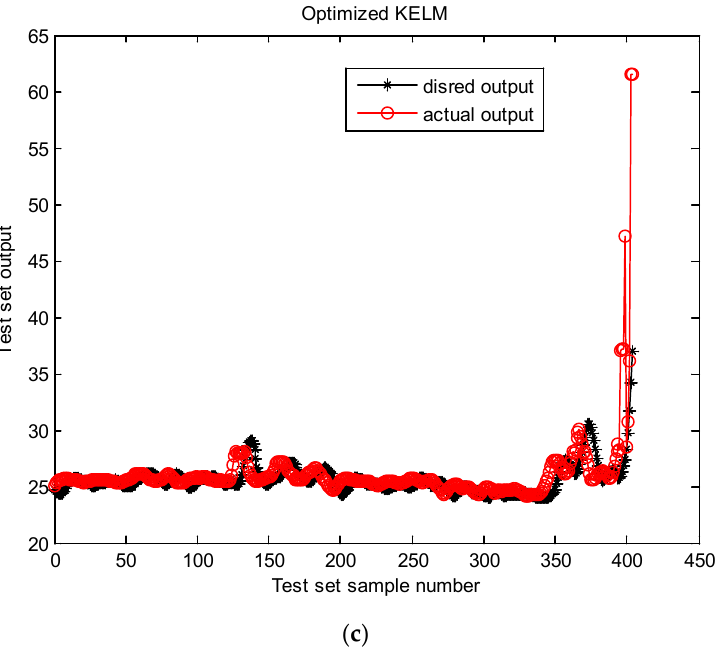
Figure 8. Actual outputs and prediction outputs in working condition 2. ( a ) Phase space; ( b ) wavelet packet space; ( c ) EEMD space.